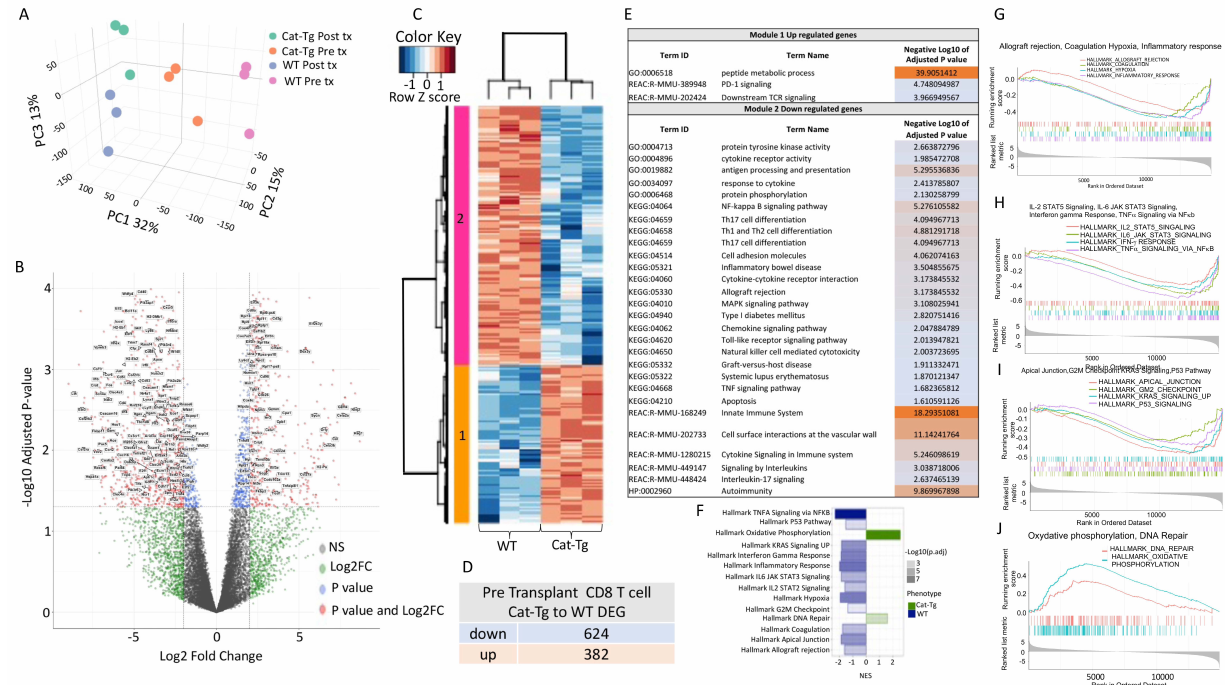
Figure 4. β -catenin overexpression differentially regulates gene expression in CD8 + T cells. ( A ) 3D graph of PCA analysis showing clustering of pre-tx and post-tx day 7 CD8 + T cells for strain and timepoint by color. All replicates are shown ( n = 3). ( B ) Volcano plot displaying 1006 differentially expressed genes (FDR 0.05, log FC 2) between Cat-Tg and WT ≤ ≥ pre-tx CD8 + T cell samples. Positive log fold change corresponds to increased expression in Cat-Tg samples. ( C ) Hierarchical clustering and heat map illustrating expression of genes compared between different groups selected by strain and timepoint. All replicates are shown (n = 3) for each group. (D) Table showing the number of up- or downregulated DEGs between groups. ( E ) Table showing GO enrichment analysis of DEG of pre-tx CD8 + T cells. Using the online tool gProfiler and the ordered g:GOSt query, we assessed which biological processes (BP) were linked to the genes in the different modules from pre-tx CD8 + T cells. On the table, adjusted p -values were color-coded as light blue for insignificant findings to orange with highest significance. ( n = 3 mice per group). ( F ) A bar plot showing up- or downregulated pathways based on enrichment scores in GSEA in pre-tx WT or Cat-Tg CD8 + T cell samples. Negative Normalized Enrichment Score (NES) is an indicator of downregulation and positive NES is an indicator of upregulation of the genes in the corresponding pathway. Color specifies the group ( WT or Cat-Tg) in which expression is altered (phenotype), color transparency indicates the negative Log10 of adjusted P-value. GSEA enrichment plots of gene clusters that are enriched in Cat-Tg cells. ( G – J ) GSEA enrichment plots of gene clusters that are enriched in WT. ( G ) Hallmark of Allograft rejection, Hallmark of Coagulation, Hallmark of Hypoxia, Hallmark of Inflammatory response, ( H ) Hallmark of IL-2 STAT5 Signaling, Hallmark of IL-6 JAK STAT3 Signaling, Hallmark of Interferon-gamma Response, Hallmark of TNFA Signaling via NF-kb, ( I ) Hallmark of Apical Junction, Hallmark of G2M Checkpoint, Hallmark of KRAS Signaling, Hallmark of P53 Pathway, and ( J ) Hallmark of DNA Repair and Hallmark of Oxidative Phosphorylation.